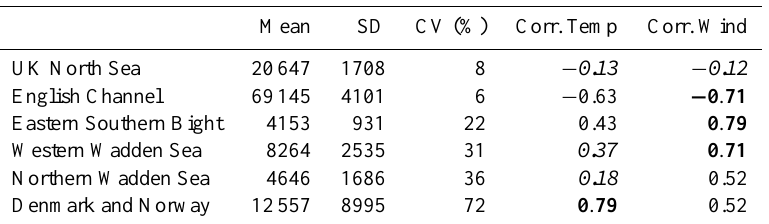
Table 2. Relationship between forcing conditions (at station d) and settlement dynamics at the different coastal zones (see Fig. 13 for a description of the different coastal zones). Bold numbers indicate a high correlation, whereas numbers in italics correspond to low correlation coefficients.